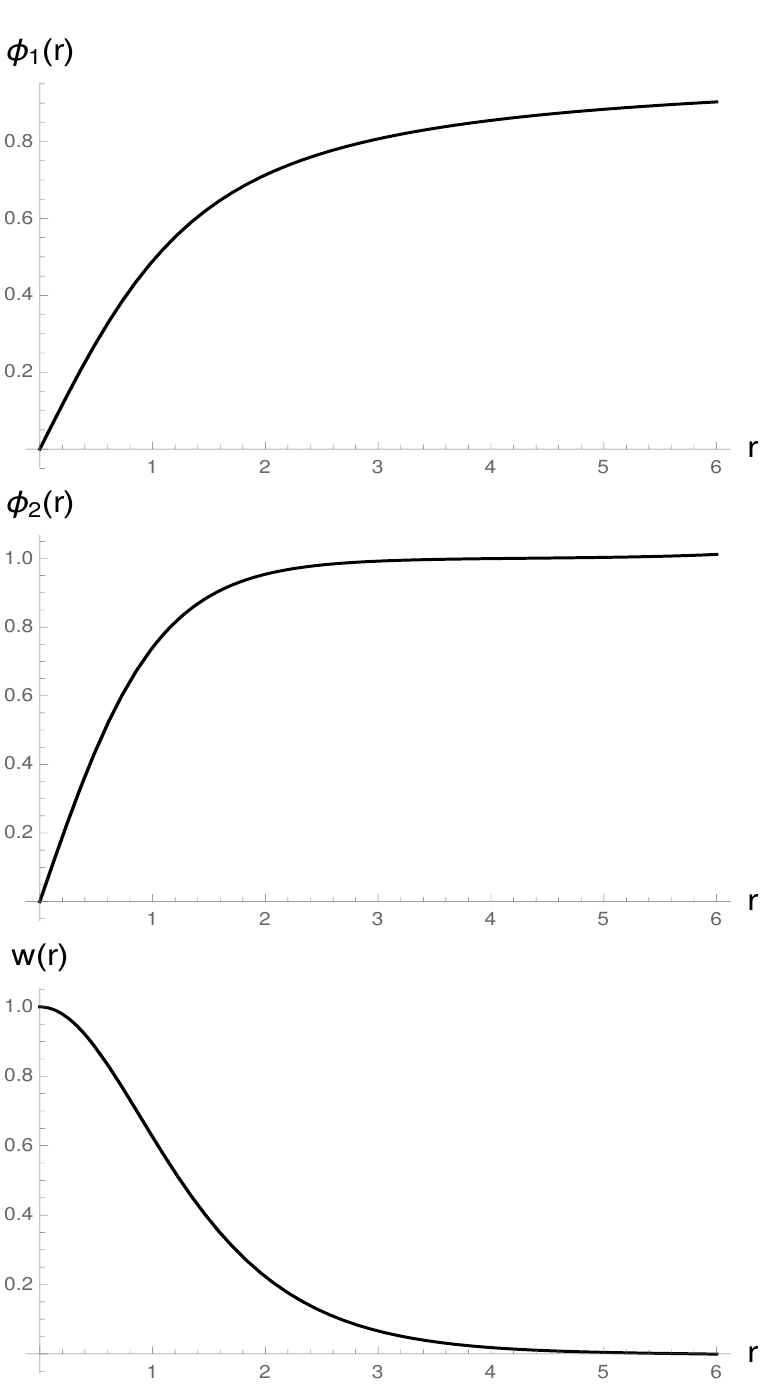
Figure 1 . In order from top to bottom, the functions (cid:30) 1 ( r ), (cid:30) 2 ( r ) and w ( r ) are shown for g = v 1 = v 2 = (cid:21) 2 =